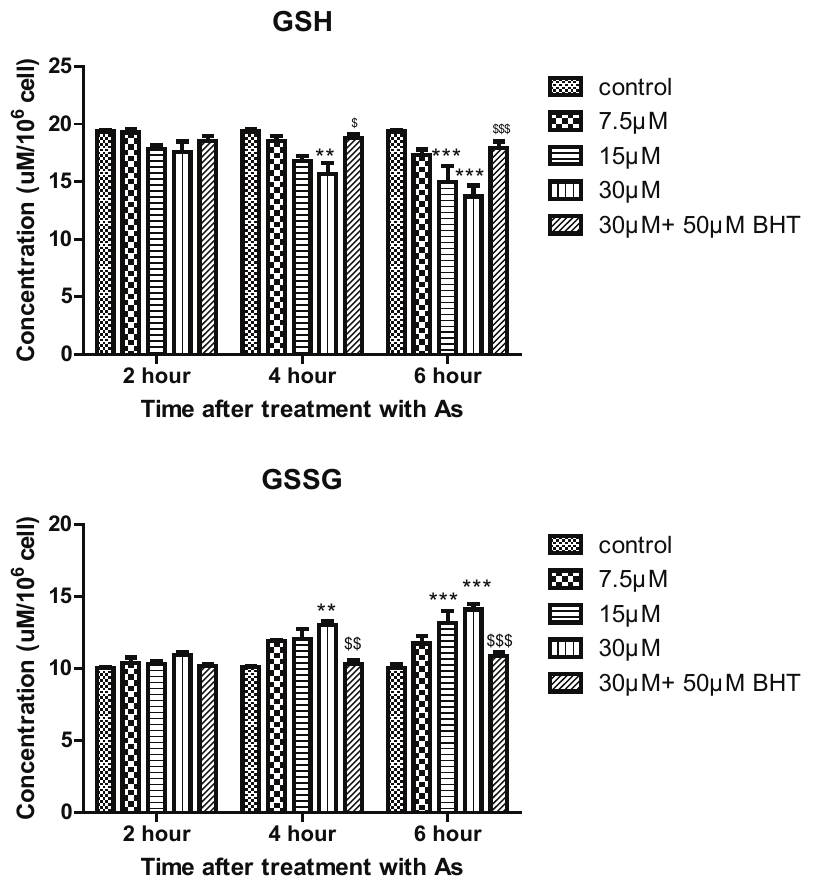
Figure 6: Influences of As treatment on levels of intracellular GSH and extracellular GSSG concentrations in human lymphocytes. Effect of As on GSH and GSSG levels determined in lymphocytes based on Hissin and Hilf approach and measurements continued until 6 h. (a,b) significant (P < 0.05) intracellular GSH decrease and raises in lymphocytes extracellular GSSG was found at 4 and 6h after treatment with As. BHT attenuated As-triggered changes in GSH and GSSG levels. ** (P < 0.01) and *** (P < 0.001): significant difference compared to the control group. $$$: significant difference with 30 µM As.